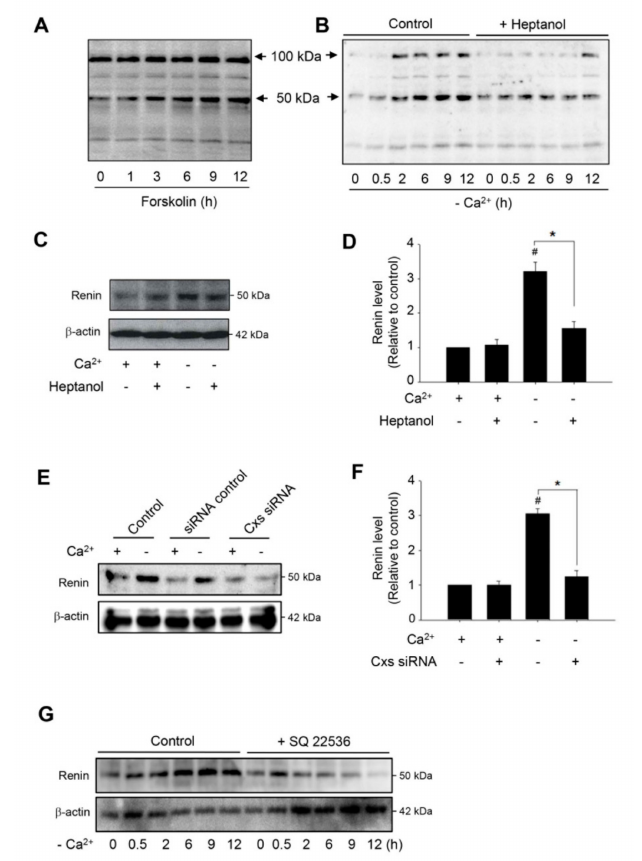
Figure 4. E ff ects of dysfunction of hemichannels on renin protein levels. ( A ) Induction of renin production by adenyl cyclase activator forskolin. ( B – D ). E ff ect of hemichannel inhibitor heptanol on renin protein levels. As4.1 cells were pretreated with 3 mM heptanol for 30 min, then treated with Ca 2 + -free medium with or without the same amount of heptanol for the indicated times ( B ) or 12 h ( C ). Cellular proteins were examined by Western blot with an anti-renin antibody. ( D ) The densitometric quantitation of the intensities of renin signal in ( C ). The data are expressed as relative intensity of the band against the control (mean ± SE, n = 4). # p < 0.01 versus normal Ca 2 + control; * p < 0.01 versus heptanol-treated cells. ( E ) Downregulation of Cxs with siRNA on renin protein levels. As4.1 cells were transfected with siRNA control or SiRNA cocktail targeting against Cx37, 40, 43 and 45 for 24 h, and then exposed to Ca 2 + -free medium for an additional 12 h. Cellular protein was extracted and subjected to Western blot analysis for renin. Expression of β -actin is shown as a loading control. ( F ) Densitometric quantitation of renin levels in D. The data are expressed as relative intensity of the band against the control (mean ± SE, n = 3). # p < 0.01 versus normal Ca 2 + control; * p < 0.01 versus siRNA-treated cells. ( G ) Influence of blockade of adenylyl cyclase on renin protein levels. As4.1 cells were pretreated with 300 µ M adenylyl cyclase inhibitor SQ 22536 for 30 min, then treated with Ca 2 + -free medium with or without the same amount of SQ 22536 for the indicated times intervals. Cellular proteins were subjected to Western blot analysis for